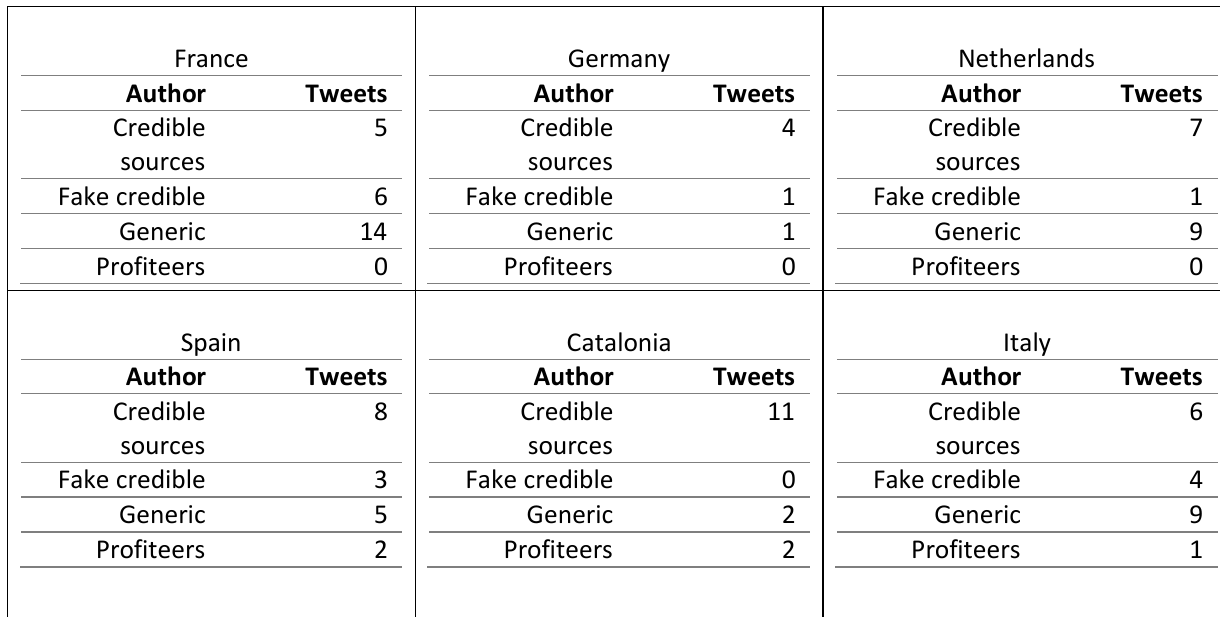
Table 2. Number of tweets containing misinformation by author type detached by